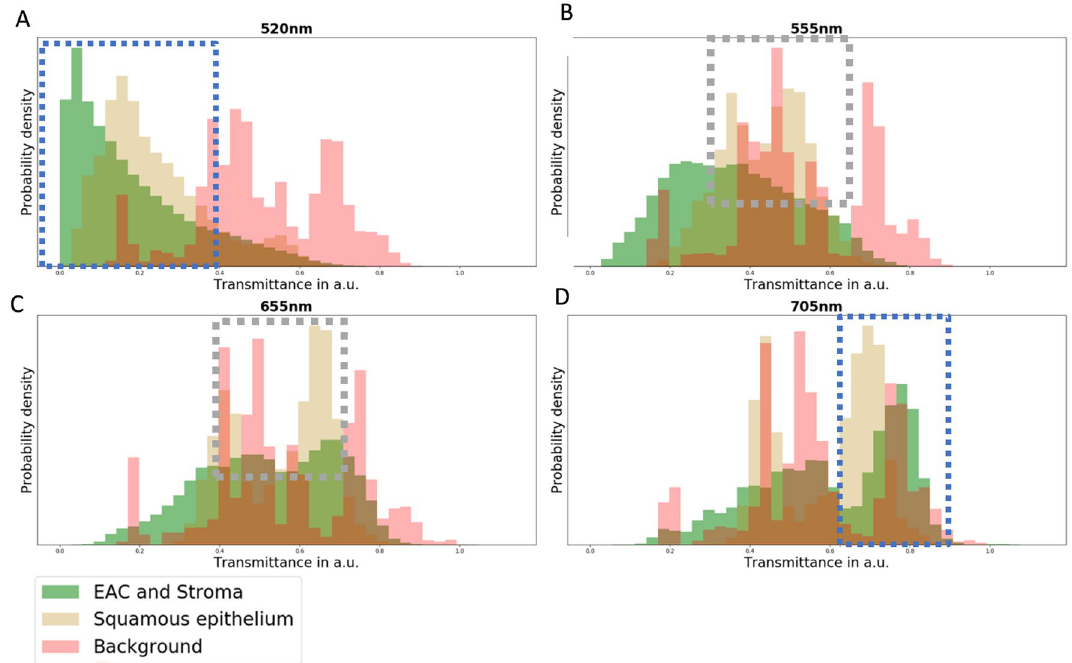
Figure 9. The histograms of the transmittance values of specific wavelengths are shown. For 520 nm ( A ) and 705 nm ( D ), the spectra of EAC, stroma, and squamous epithelium showed a high similarity in the probability densities (blue dotted rectangle). For the wavelengths, 655 nm ( C ) and 555 nm ( B ), the spectra of EAC and stroma against squamous epithelium showed differences in the probability density (grey dotted rectangle). Hence, the spectra values between 560 and 675 nm were used to classify these four structures. (a.u. aberrante